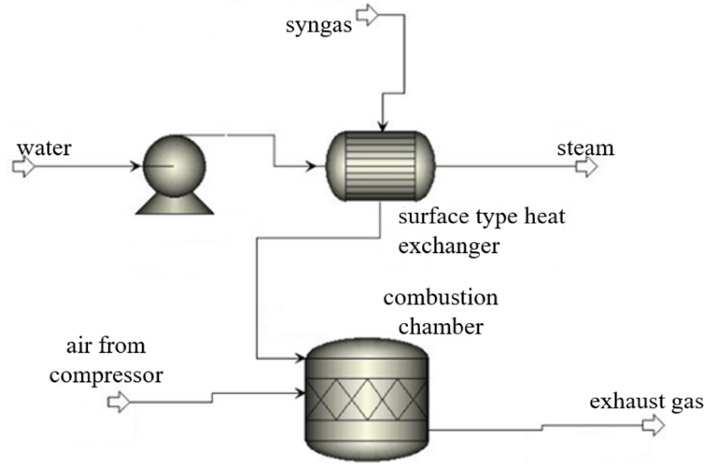
Figure 3. Additional heat exchanger for the gasification steam production.